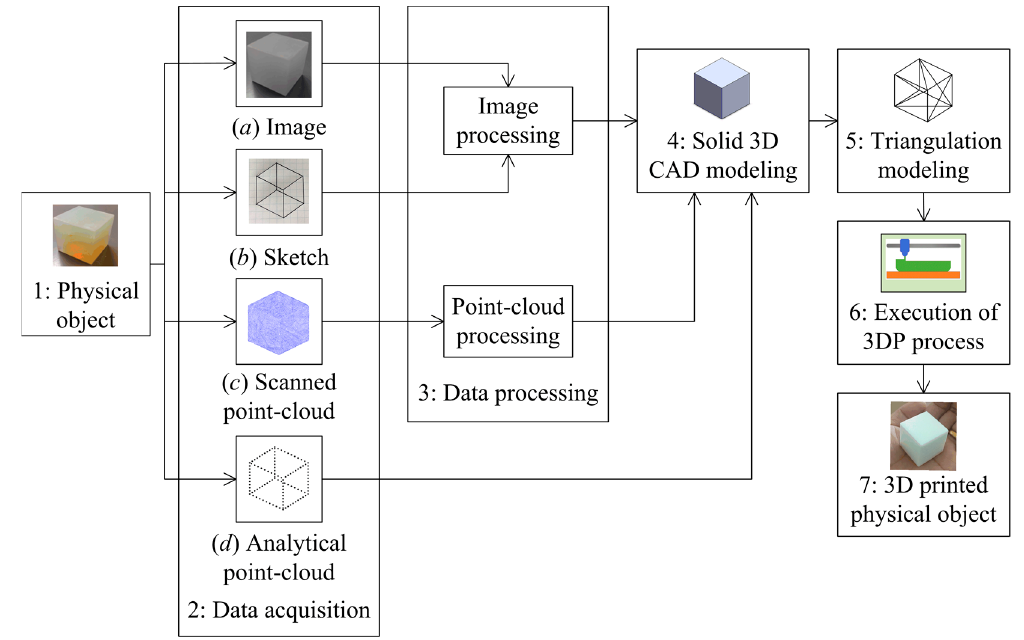
Figure 1. Additive manufacturing from the viewpoint of reverse engineering.